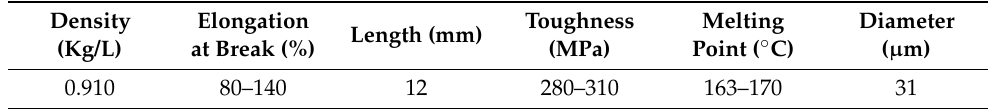
Table 4. Properties of Polypropylene Fibers.